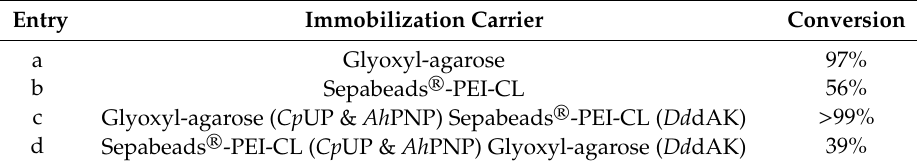
Table 1. Synthesis of araA-MP catalyzed by immobilized Cp UP, Ah PNP and Dd dAK (reaction assay conditions) 1